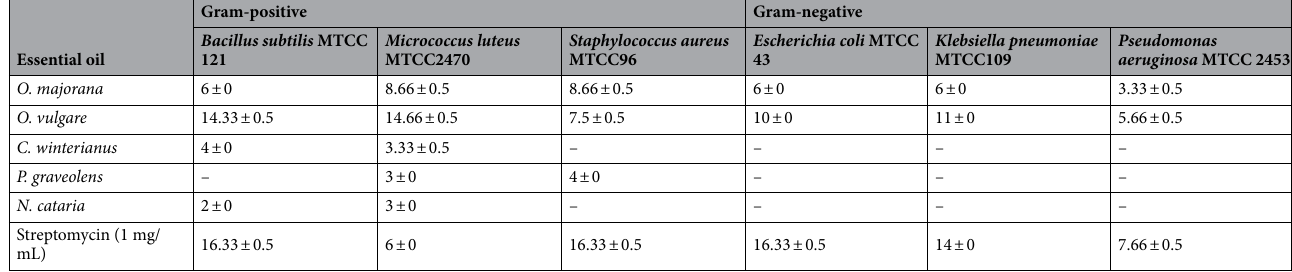
Table 3. Antibacterial activity of the essential oils against Gram-positive and Gram-negative bacterial strains. The values are mean ± standard deviation. Values are means ± Standard Deviation (SD) of triplicate readings expressed in mm including 6 mm of well diameter.